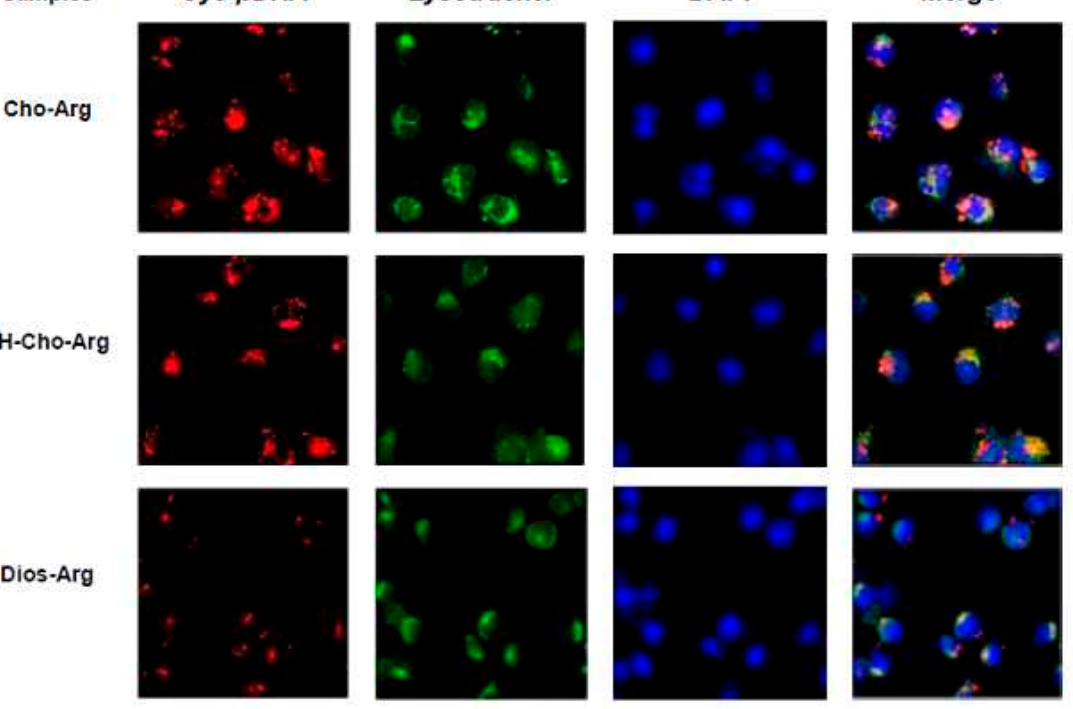
Figure 8. Fluorescence images (400×) for intracellular localization of the steroid-based cationic lipids/Cy3-pDNA lipoplexes after 4 h incubation in H1299 cells. Lipofectamine2000 (Lipo2000) was used as a reference. Red: Cy3-labeled pDNA; green: Lysotracker stained endosome/lysosome; blue: DAPI stained cell nuclei. 4. Conclusions In summary, we successfully prepared a series of new steroid-based cationic lipids by incorporation of modular steroid hydrophobes and ( l -)-arginine headgroup via facile and efficient synthetic approach. The study on the physico-chemical properties showed that the pDNA binding